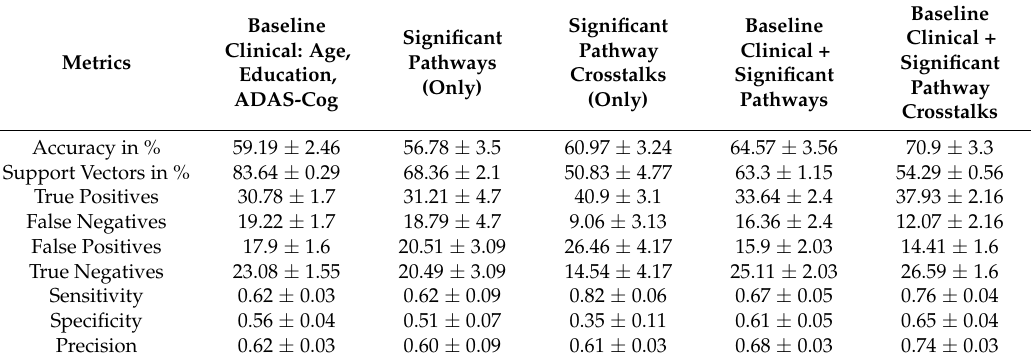
Table 3. Performance of support vector machine (SVM) models with baseline clinical parameters. Baseline Clinical: Metrics